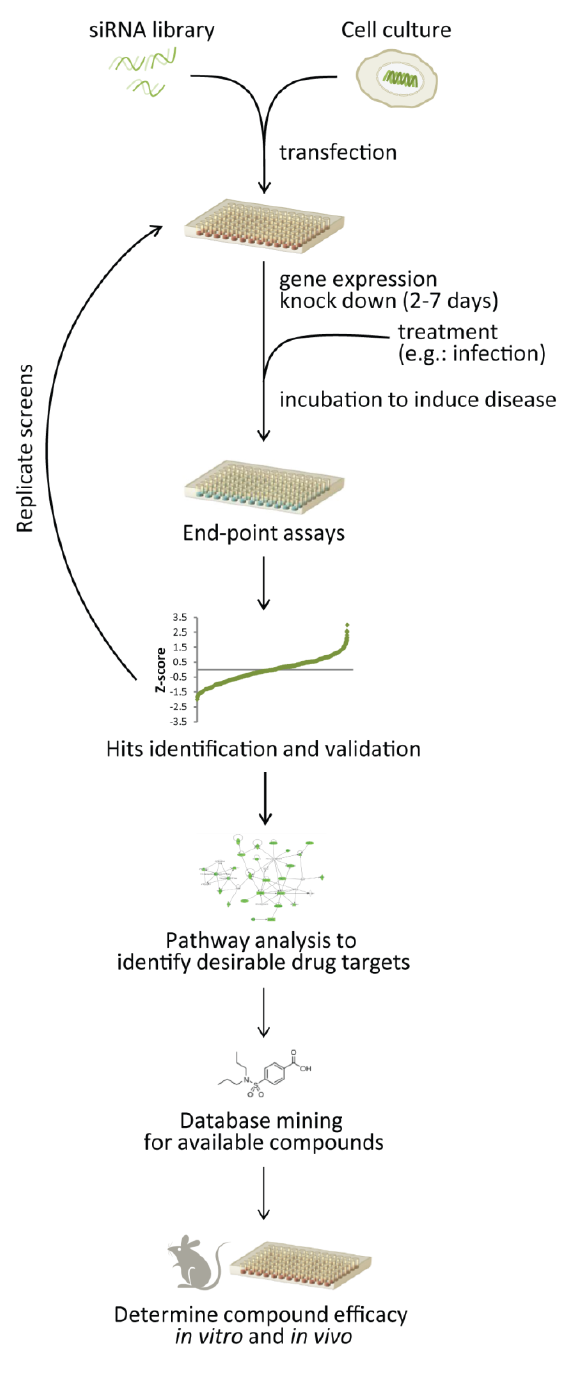
Figure 2. Strategies for siRNA screening process to identify new therapeutic target toward drug repurposing. Following primary and secondary screens, potential gene targets are further analyzed in silico using pathway analyses and database mining to determine desirable drug targets and available compounds. Efficacy and safety of these compounds can then be assessed in vitro and in vivo before clinical trials can be